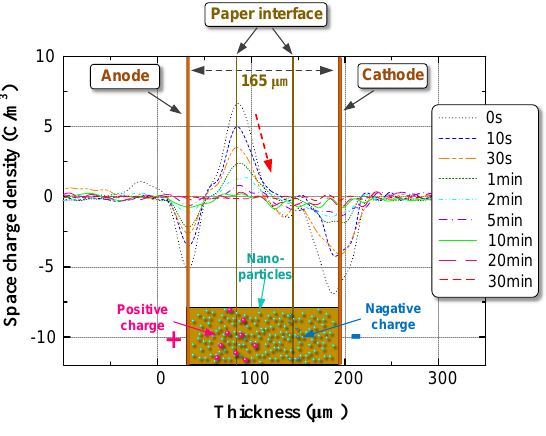
Figure 15. Space charge decay characteristics of NOIP at a nanoparticle concentration of 0.015 g/L.